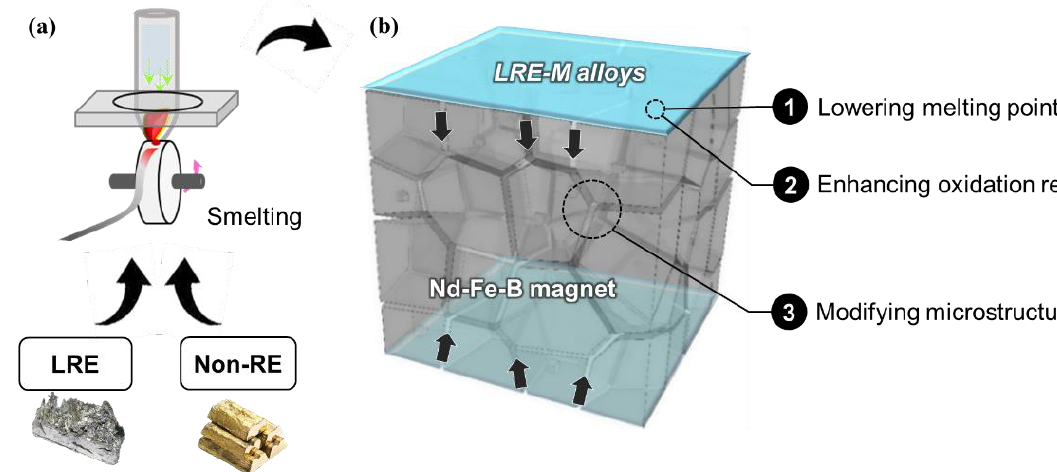
Figure 3. ( a ) Fabrication of LRE-M diffusion alloys, and ( b ) design principles in selecting non-RE alloy elements.